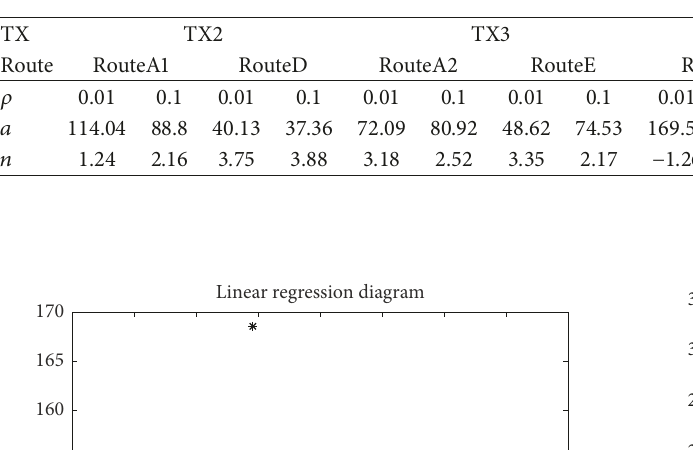
Table 3: TX2, TX3, TX4, and TX5 each receive route 𝑎 and 𝑛 .